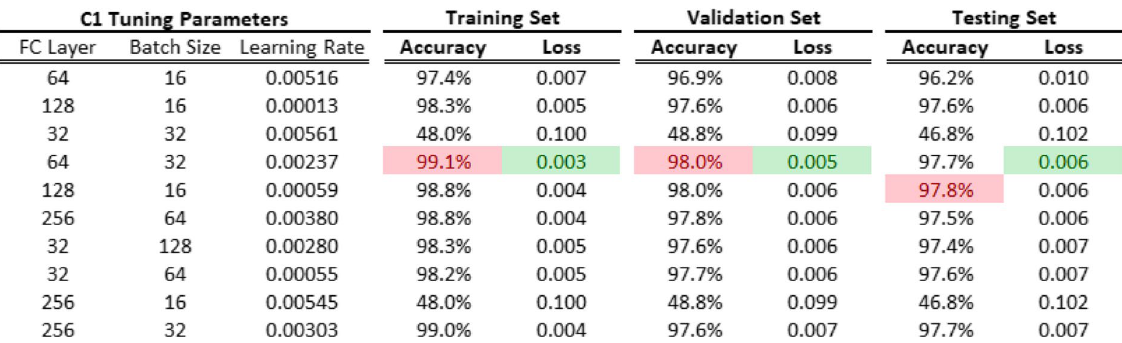
Table 5 Hyperparameter tuning for C1